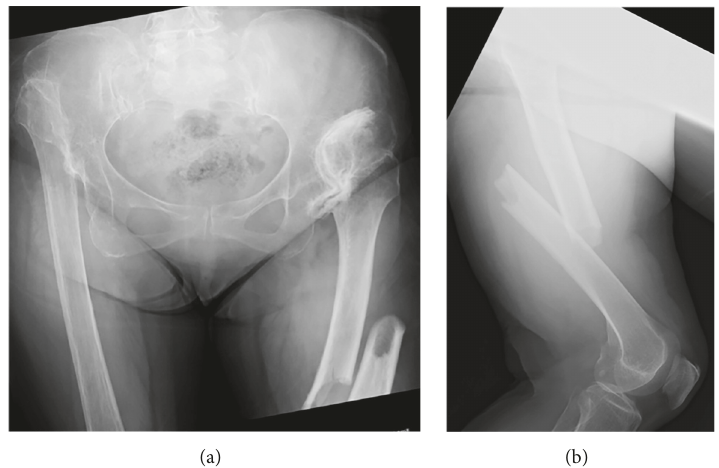
Figure 2: (a) AP and (b) lateral radiographs show a characteristic atypical femoral fracture and severe osteoarthritis of the hip.